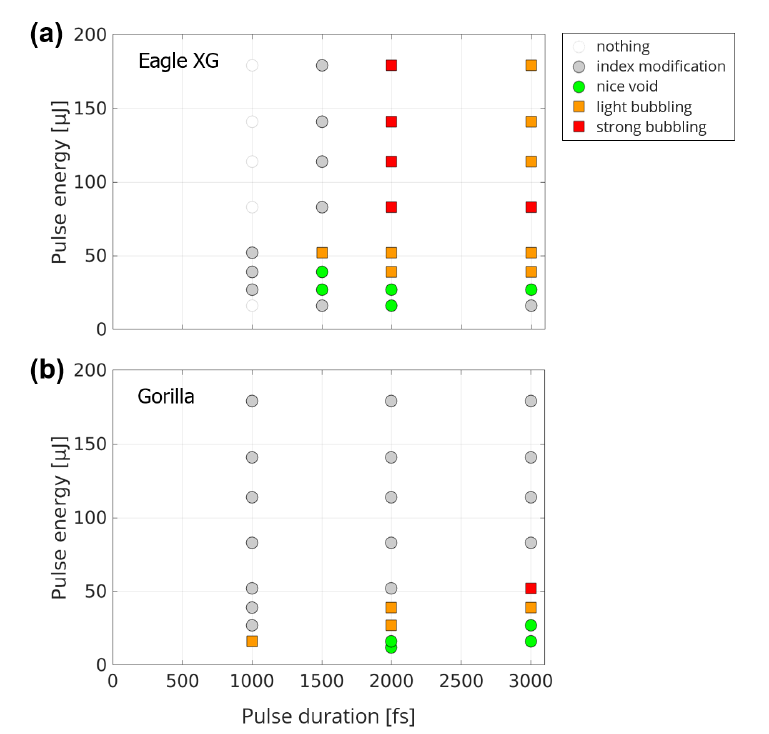
Figure 6. Morphology of single shot-induced damage in ( a ) Eagle XG and ( b ) Gorilla glass as a function of pulse energy and pulse duration. Beam is centered inside sample.